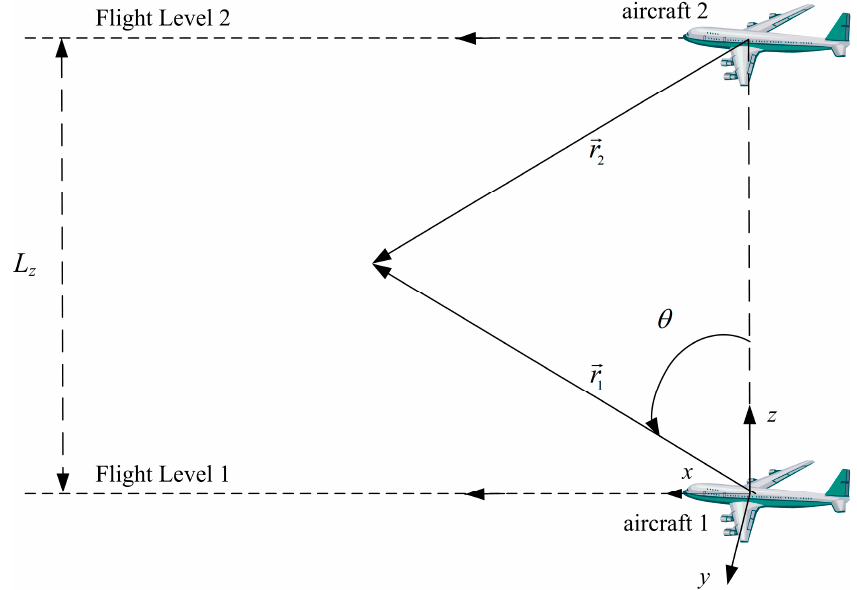
Figure 2. Two aircraft flying along parallel straight flight path with constant separation distance Lz , with the first having a position drift coincidence anywhere in three dimensions.